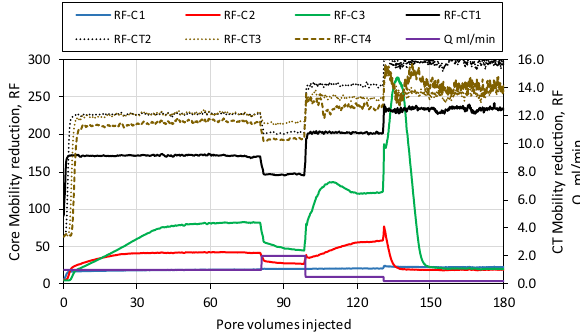
Fig. 4 Experiment 1a. 1000 ppm A06 in SSW in Bentheimer. RF pm as a function of pore volumes injected in Core 1 (C1 at 20 °C), Core 2 (C2 at 30 °C), Core 3 (C1 at 60 °C), and RF CT for the capillary tube 1 (CT1 at 20 °C, upfront Core 1), capillary tube 2 (CT2 at 30 °C, upfront Core 2), capillary tube 3 (CT3 at 60 °C, upfront Core 3), and capillary tube 4 (CT4 also at 60 °C, but after Core 3). The volumetric injection rate is 1 ml/min for 74 pore volumes and is thereafter decreased to 0.2 ml/min for 3 additional pore volumes